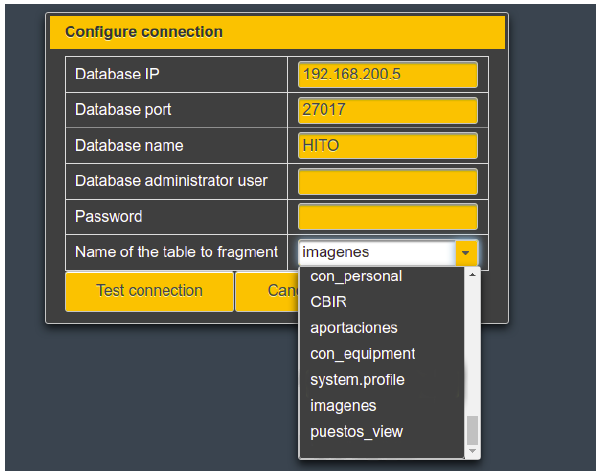
Figure 4. XAMANA web application home page.